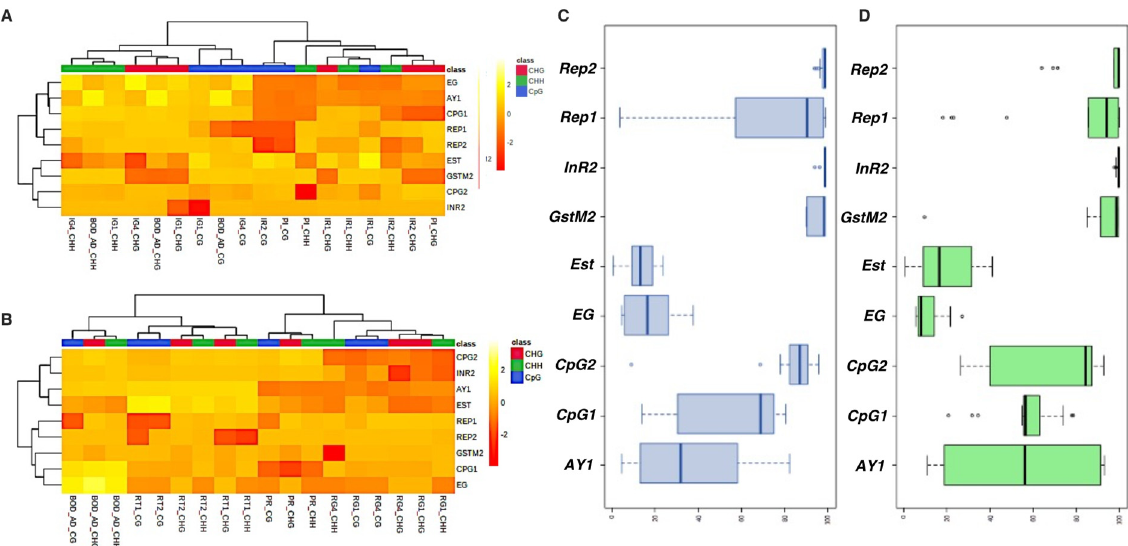
Figure 5. Estimation of variability in methylation levels of genes, across BPH populations (adults), when subjected to stress. ( A ) Heatmap depicting alterations in the methylation status of stress- responsive genes upon exposure to imidacloprid. ( B ) Fluctuations (in methylation of genes) observed under nutritional stress (RH). ( C ) Whisker plots depicting the degree of variability (viz. methylation) exhibited by genes under pesticide stress. ( D ) under nutritional (RH) stress. Mean values, quartiles, standard deviation, and outliers are indicated.